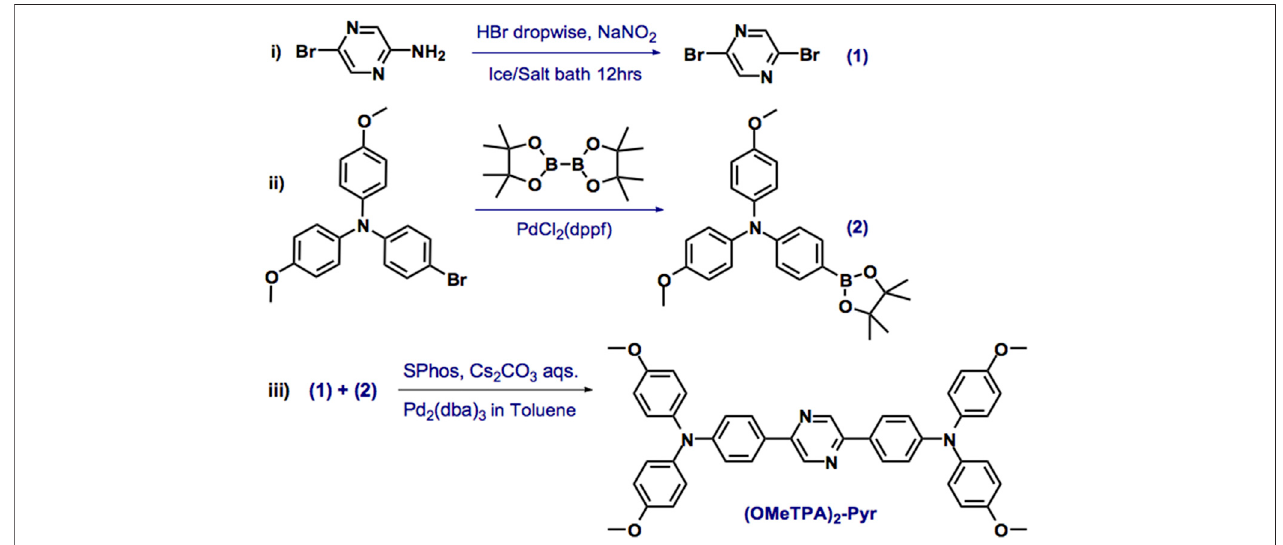
FIGURE 1 | Energies and electronic orbital localizations of (OMeTPA)2-Pyr in its representative Frontier molecular orbital distributions.